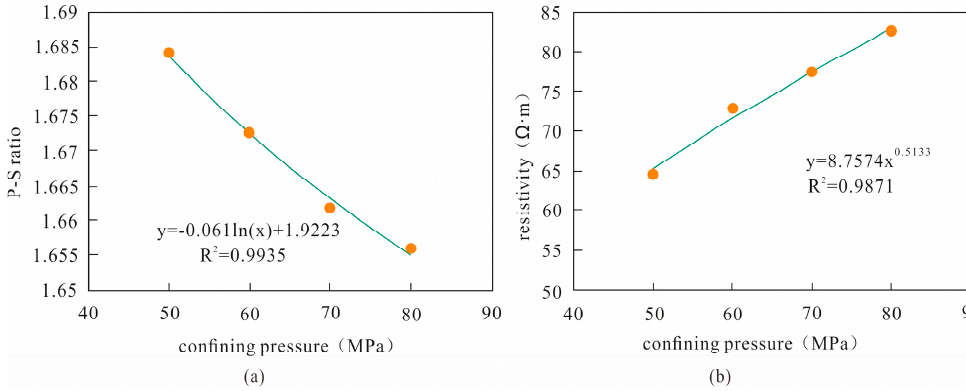
Figure 12. Relationship curves between P-S wave ratio, resistivity and confining pressure.